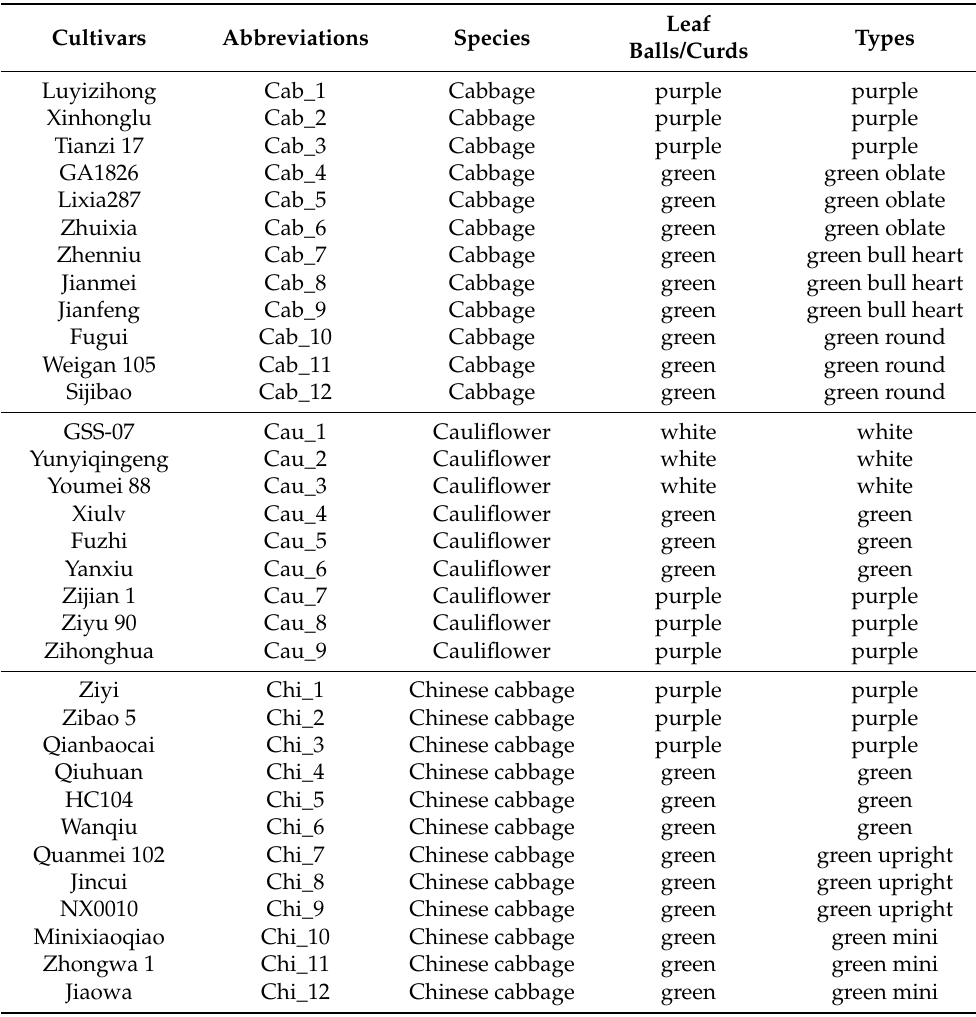
Table 2. Information on the varieties examined in this